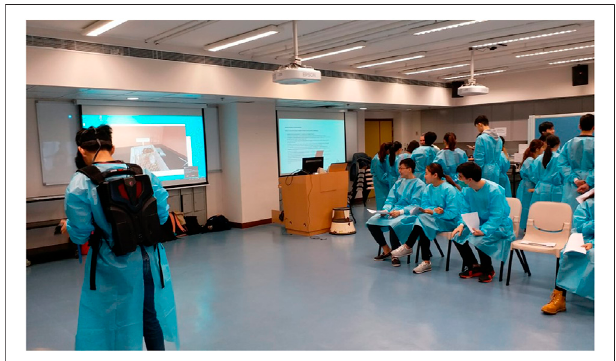
FIGURE 1 | The student player wore the VR gear and played the ViSi. The classmates sat aside engaged in the learning process by discussing the accurate or wrongdoing behaviours performed by the